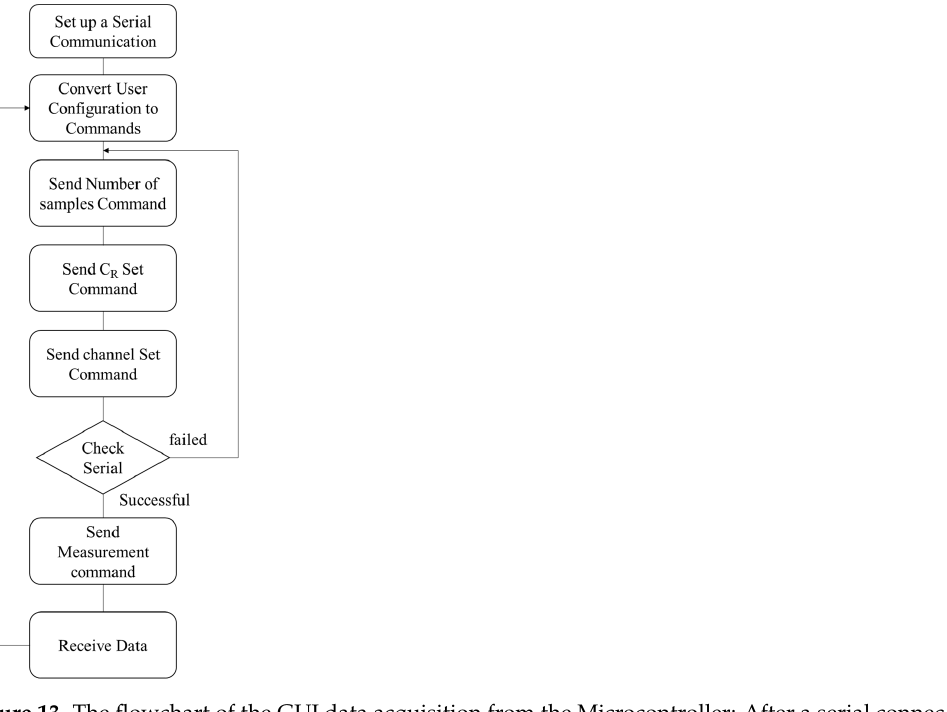
Figure 13. The flowchart of the GUI data acquisition from the Microcontroller: After a serial connec- tion is set up between the GUI and the microcontroller, the user can input all the settings shown in Figure 12a. The GUI generates three commands based on the user settings and sends them to the microcontroller. Then, the serial port is checked again before establishing the measurement com- mand on the serial port. Next, the data is received from the chip and read from the microcontroller’s SPI port buffer. After a serial communication channel has been established between the GUI and the microcontroller unit (MCU), the GUI converts the user input settings to four different types of command, namely the number of samples, and the value of the reference